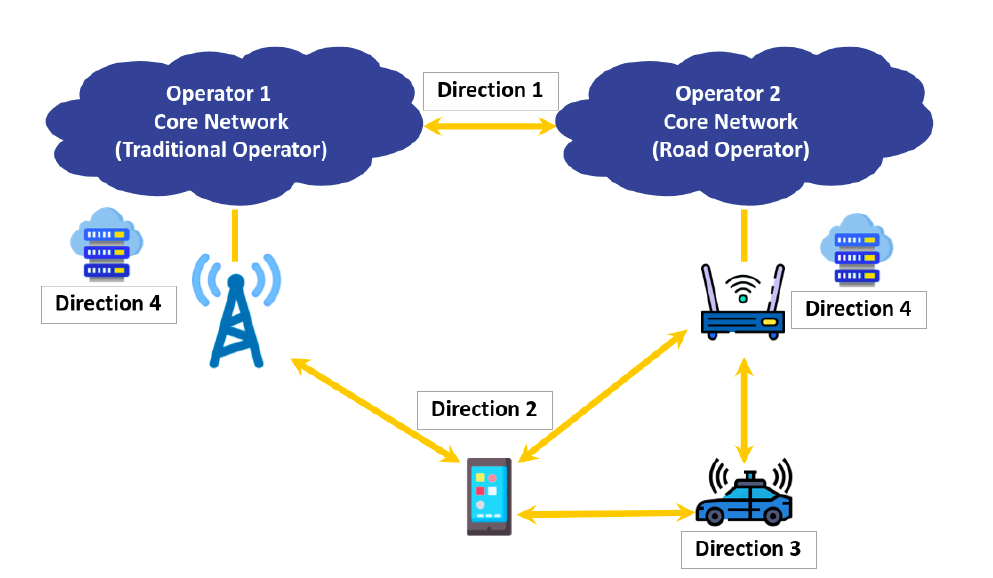
Figure 3. Presentation of potential future directions for multi-connectivity in 5G networks and